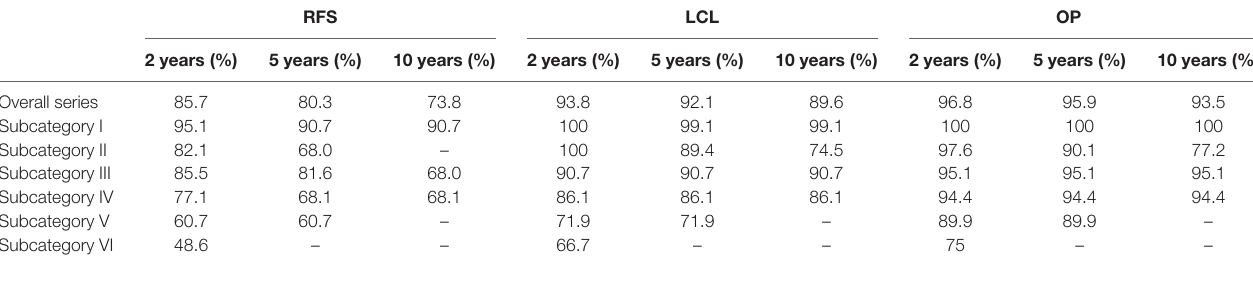
Table 1 | Recurrence-free survival (RFS), local control with laser alone (LCL), and organ preservation (OP) at 2, 5, and 10 years for each subcategory. rFs